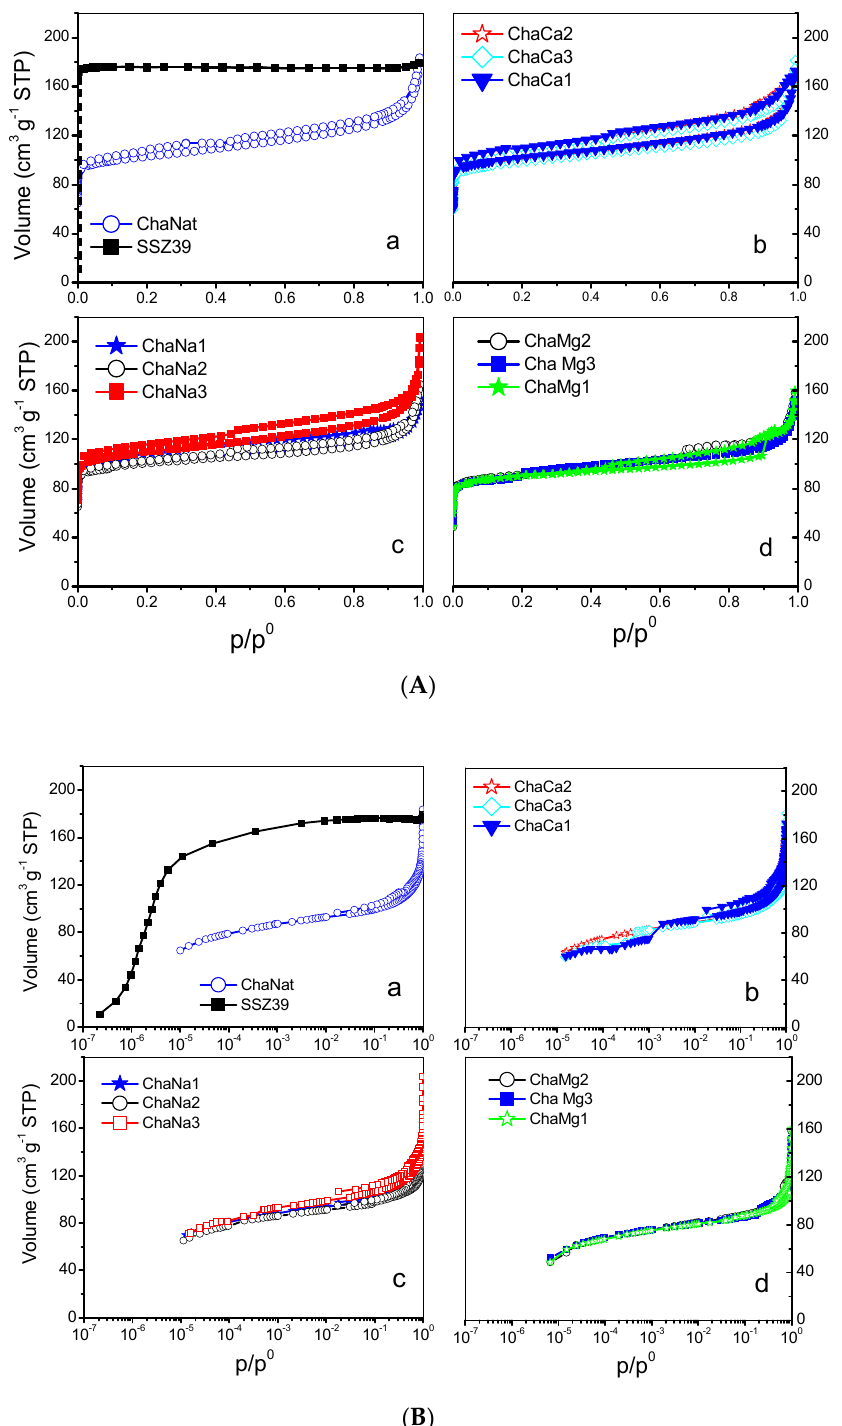
Figure 4. ( A ) N 2 adsorption isotherms at 77 K in CHA zeolites. ( B ) N 2 adsorption isotherms at 77 K in CHA zeolites, logarithmic